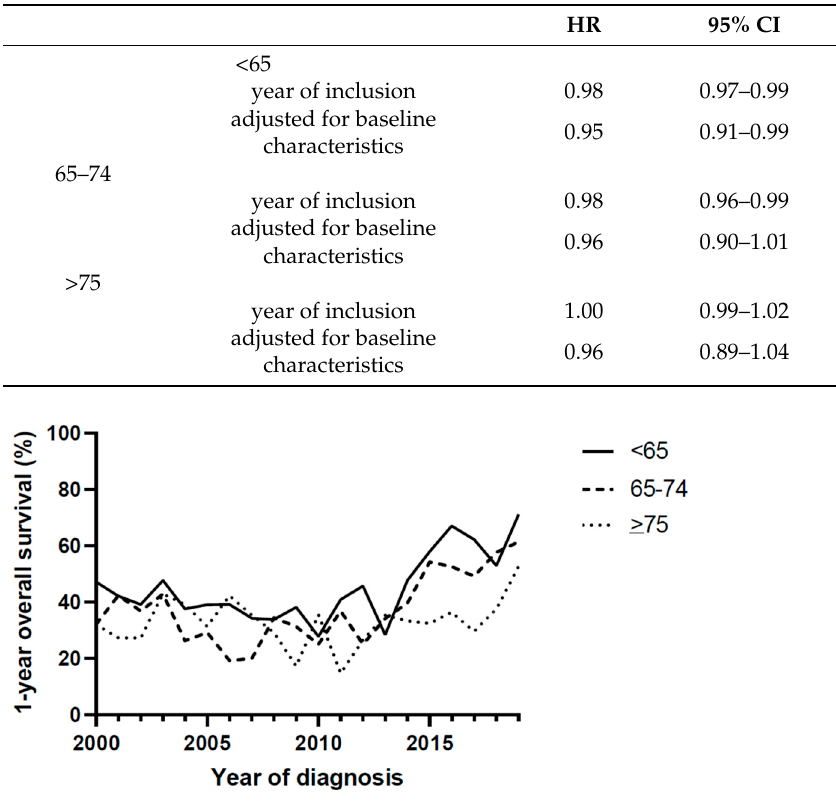
Table 2. Overall survival by age (<65 vs. 65–74 vs. ≥ 75). Adjusted analyses were adjusted for gender, tumour location, number of metastases, number of positive lymph nodes, and Breslow thickness.